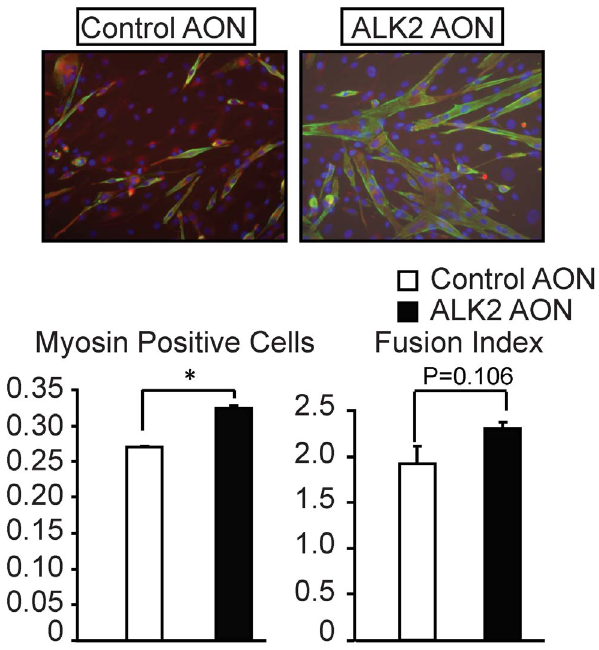
Figure 3. ALK2 AON enhanced myogenic differentiation in C2C12 cells. C2C12 cells were transfected with 200 nM control AON or 200 nM ALK2 AON in differentiation medium for 7 days. Then cells were immunostained with myosin and desmin. Myosin (green) was used to label the differentiated cells while desmin (red) was used to label myogenic cells. The values for the percentage of myosin positive cells or for the fusion index represent the average levels of two independent samples. Values and error bars represent the means 6 SD. Statistical analysis was performed using Student’s t-test, using the untransfected samples as reference. *P , 0.05.